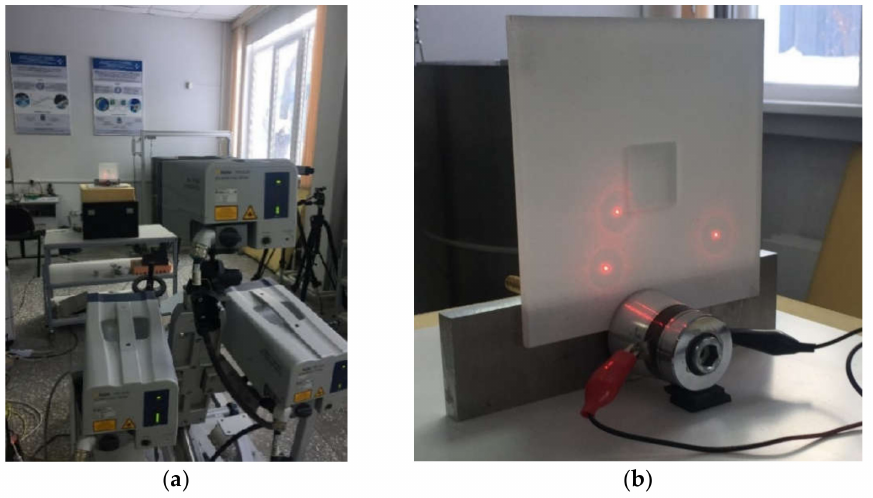
Figure 2. 3D scanning laser Doppler vibrometer experimental set-up ( a ) and piezoelectric transducer attached to sample ( b